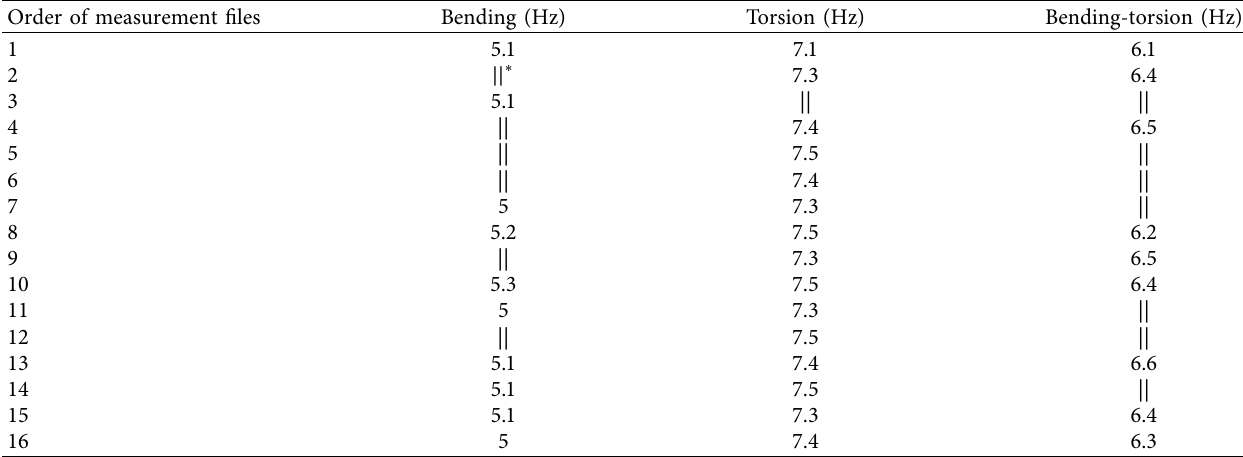
Table 5: Statistics of frequencies of Binh Phuoc 2 flyover from different measurement times (obtained from LAM). Order of measurement files